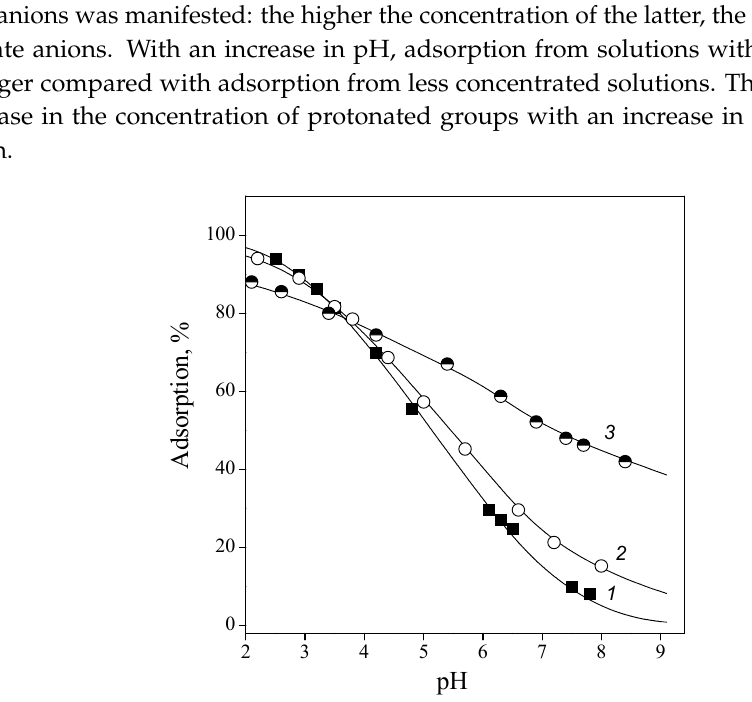
Figure 7. Adsorption of IMP on a titanium oxide surface as a function of ionic strength: 0.001 ( 1 ), 0.01 ( 2 ), and 0.1 ( 3 ) M NaCl. C IMP = 0.1 mmol/l, and C TiO2 = 1 g/L.